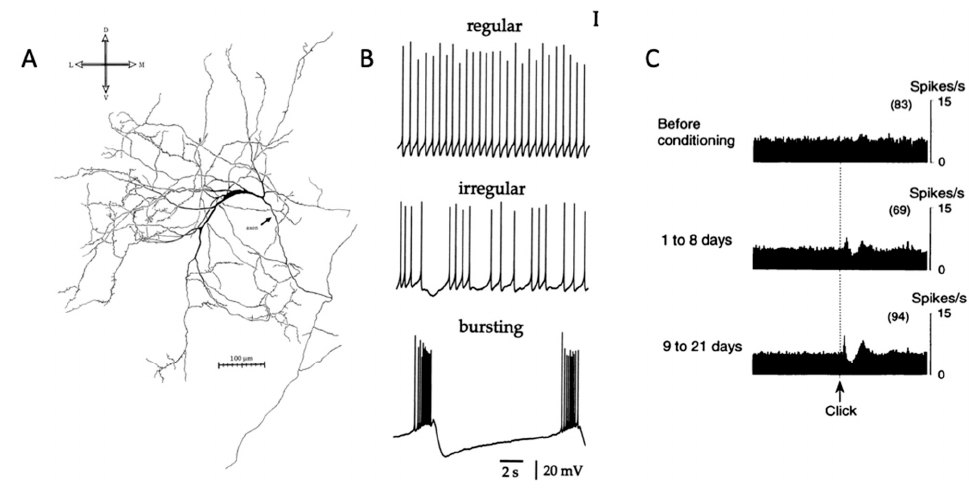
Figure 1. Striatal cholinergic interneuron anatomy and physiology. ( A ) Image of striatal cholinergic interneuron [8]. ( B ) Firing patterns of CIN in brain slice [44]. ( C ) Pause response of presumed CIN to salient stimulus [29]. Permissions requested for use of figures.